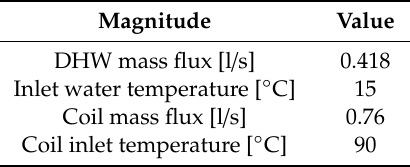
Table 1. Boundary conditions of the simulation in continuous